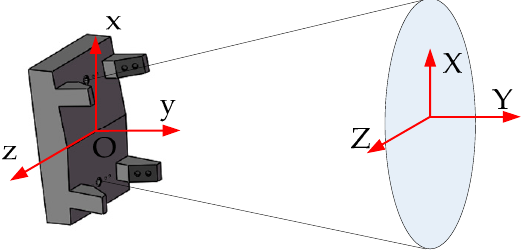
Figure 2. Definition of coordinate system.